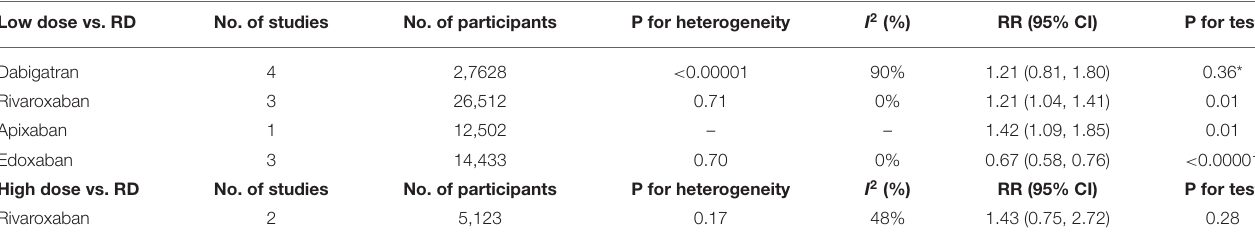
TABLE 7 | Major or clinically relevant bleeding of low/high dose of individual NOACs compared to recommended dose. Low dose vs.